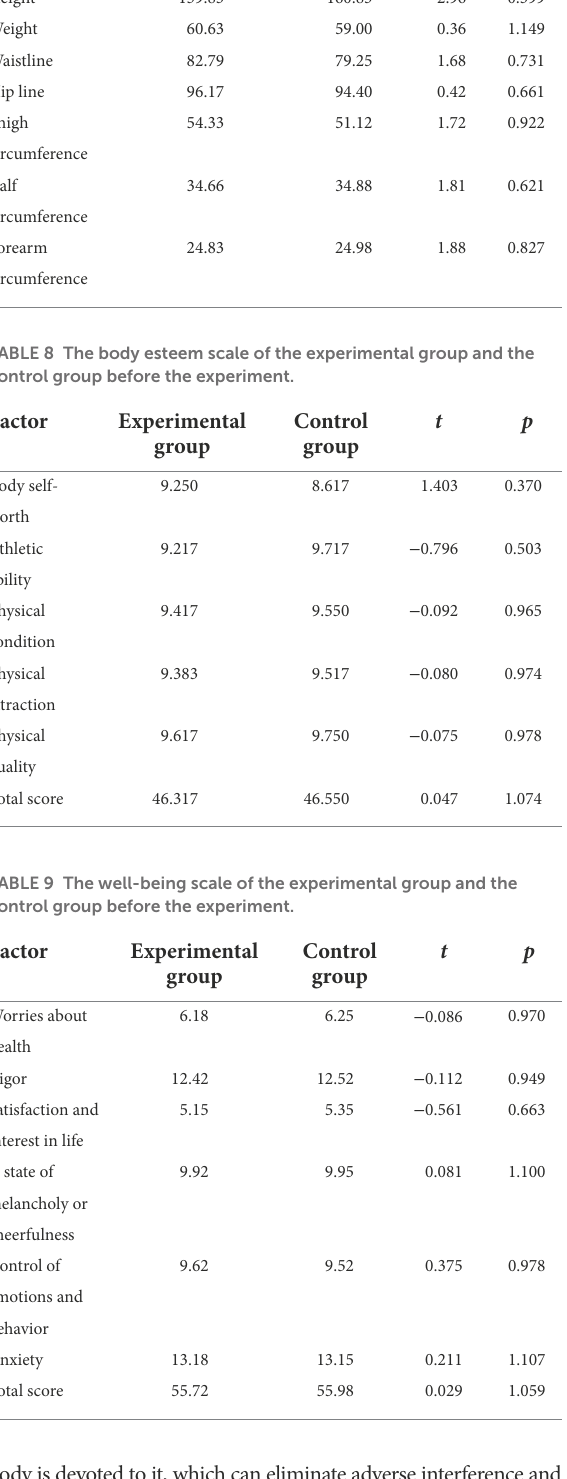
TABLE 7 Physical characteristics of the silver-haired people in the experimental group and the control group before the experiment. Factor Experimental group